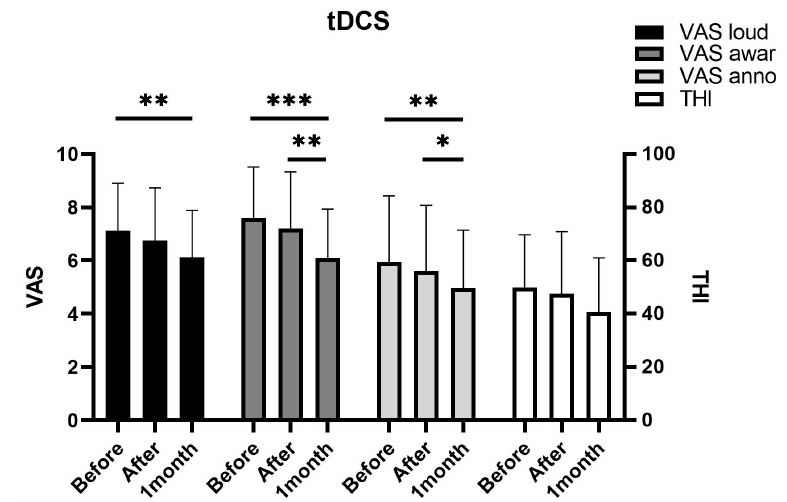
Figure 2. Transcranial direct current stimulation (tDCS) reduces tinnitus symptoms. The tDCS group showed reduction of tinnitus symptoms evaluated by the visual analog scale and tinnitus handicap inventory survey at 1 month after treatment. A significant reduction was noted between immediately after the treatment and 1 month after the treatment. (* p < 0.05; ** p < 0.01; *** p < 0.001; analyzed using repeated measure analysis of variance). Table 2. Comparison of treatment results between rTMS and